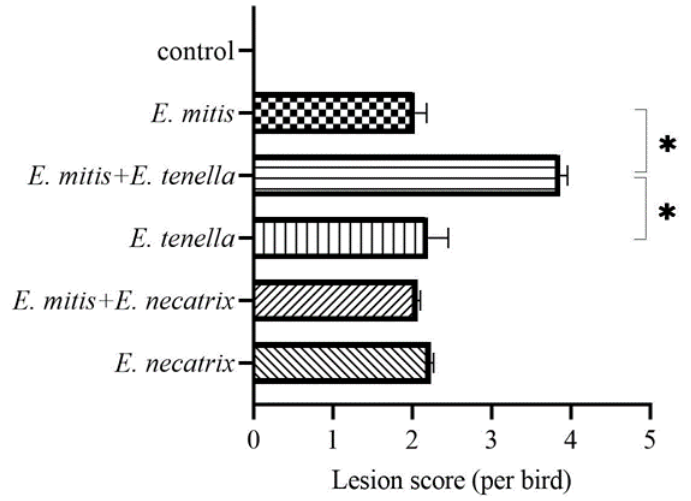
Figure 1. The lesion score of chicken intestines with single and mixed infections of Eimeria species. The asterisk denotes that two groups significantly differed ( p < 0.05).